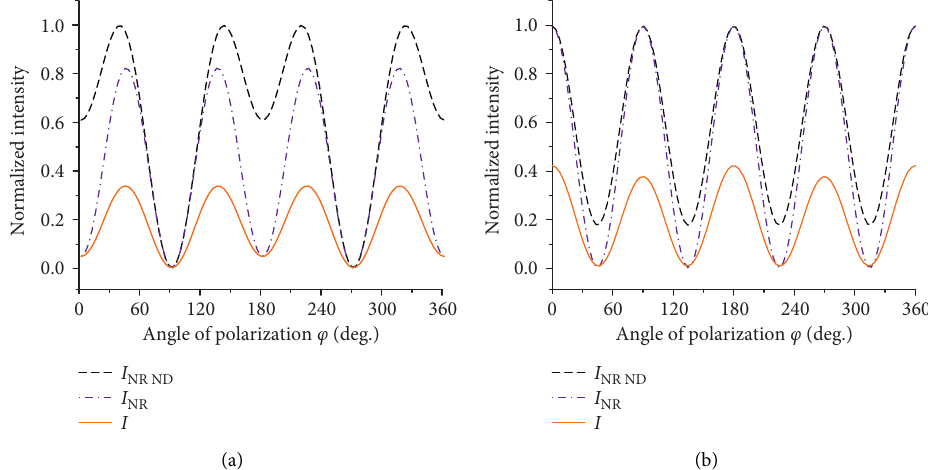
� β � 30 ° ) for different polarization directions φ i s